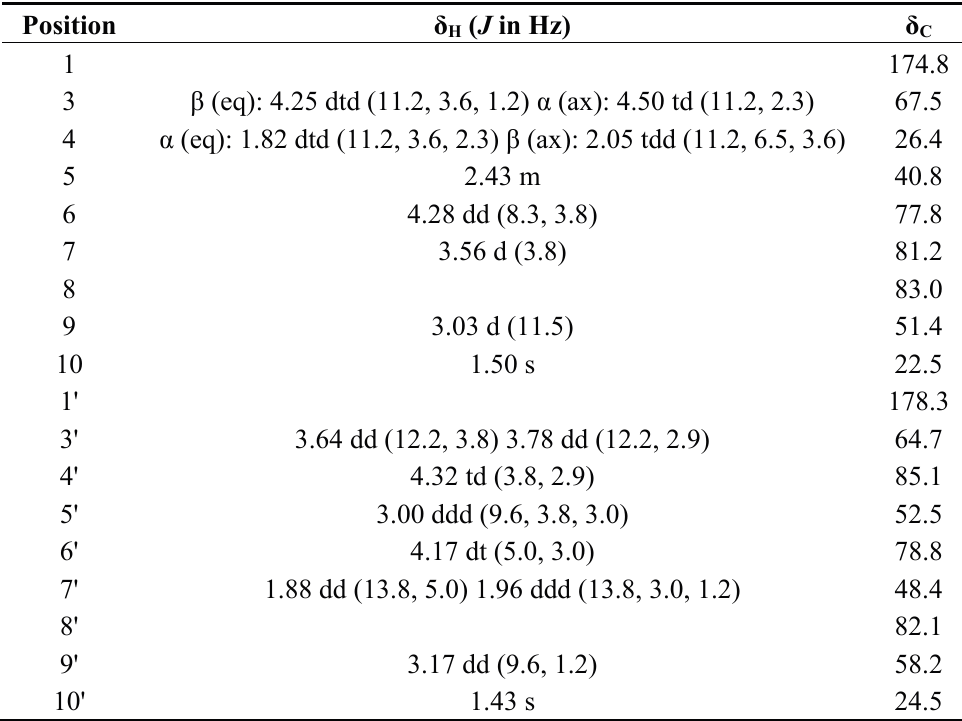
Table 2. 1 H- and 13 C-NMR spectroscopic data for compound 5 in CD 3